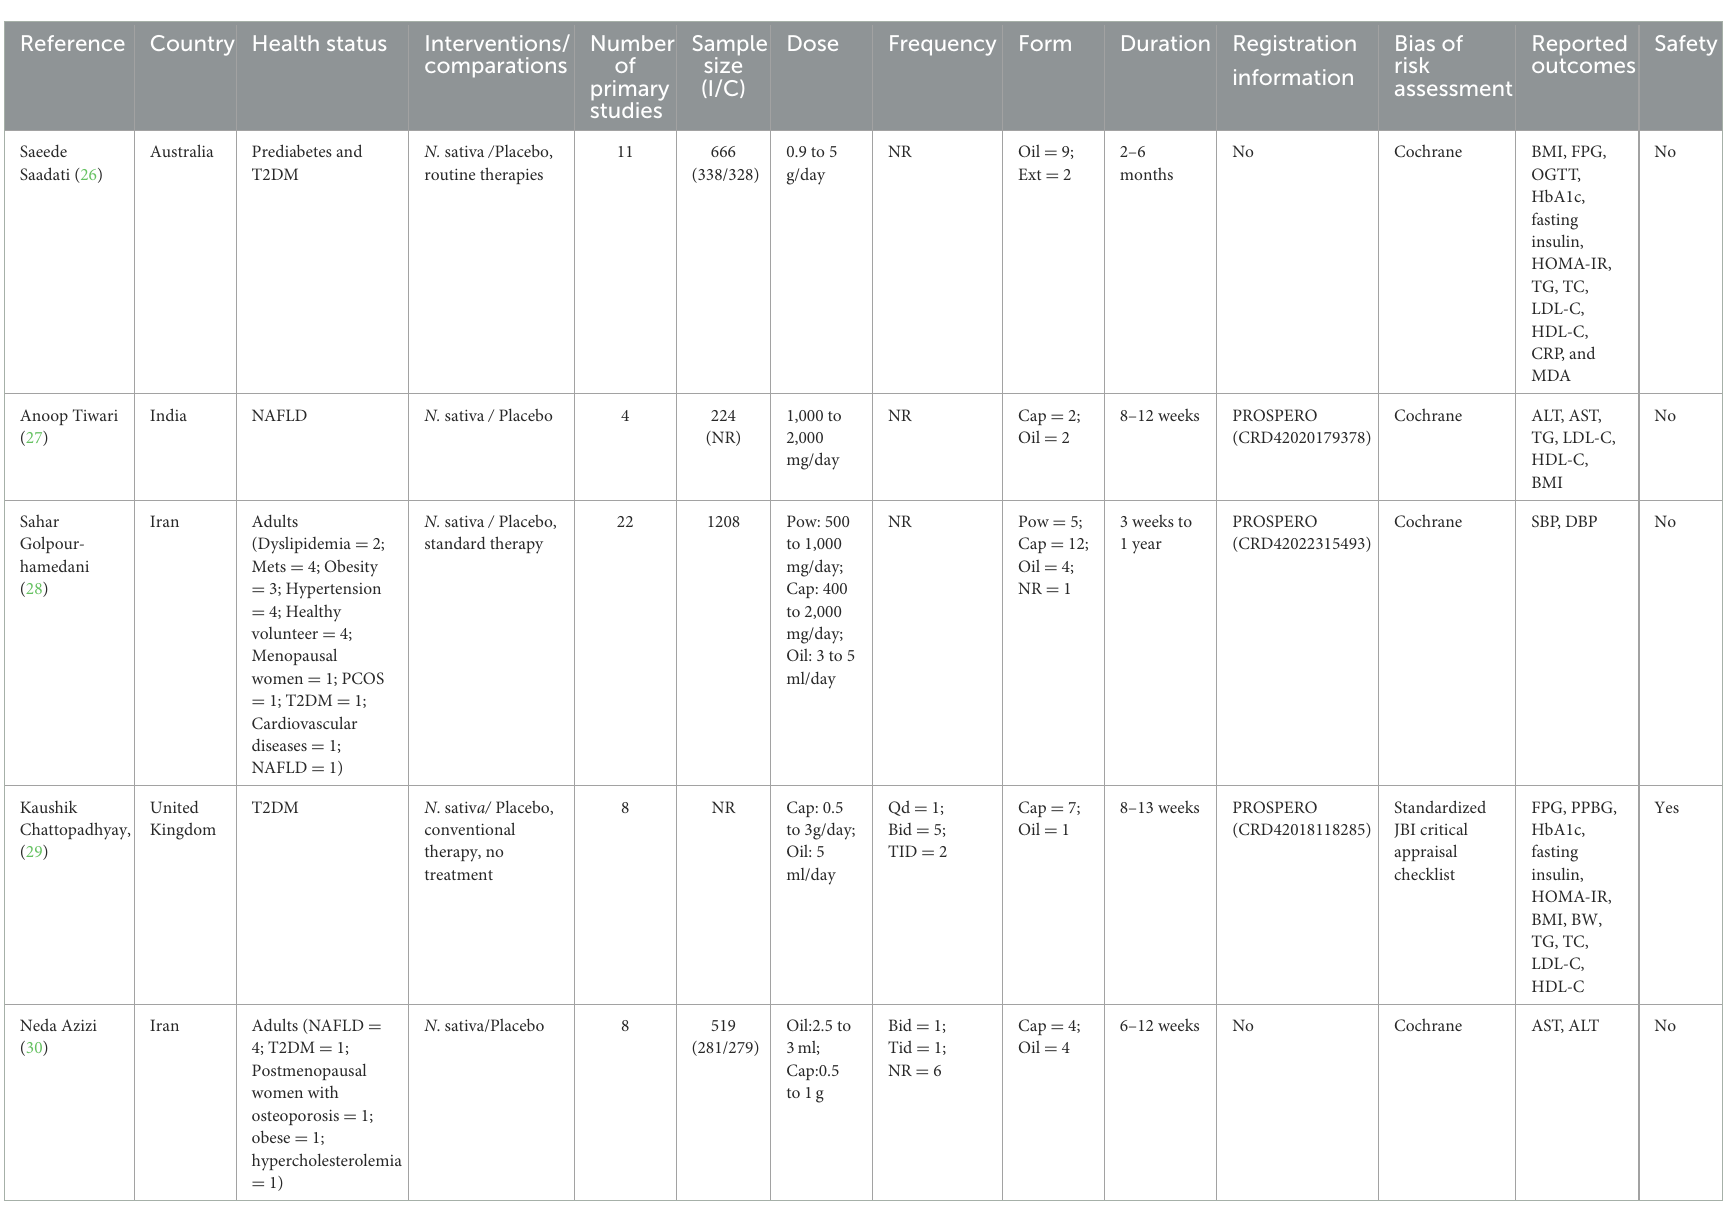
TABLE 1 Characteristics of the included